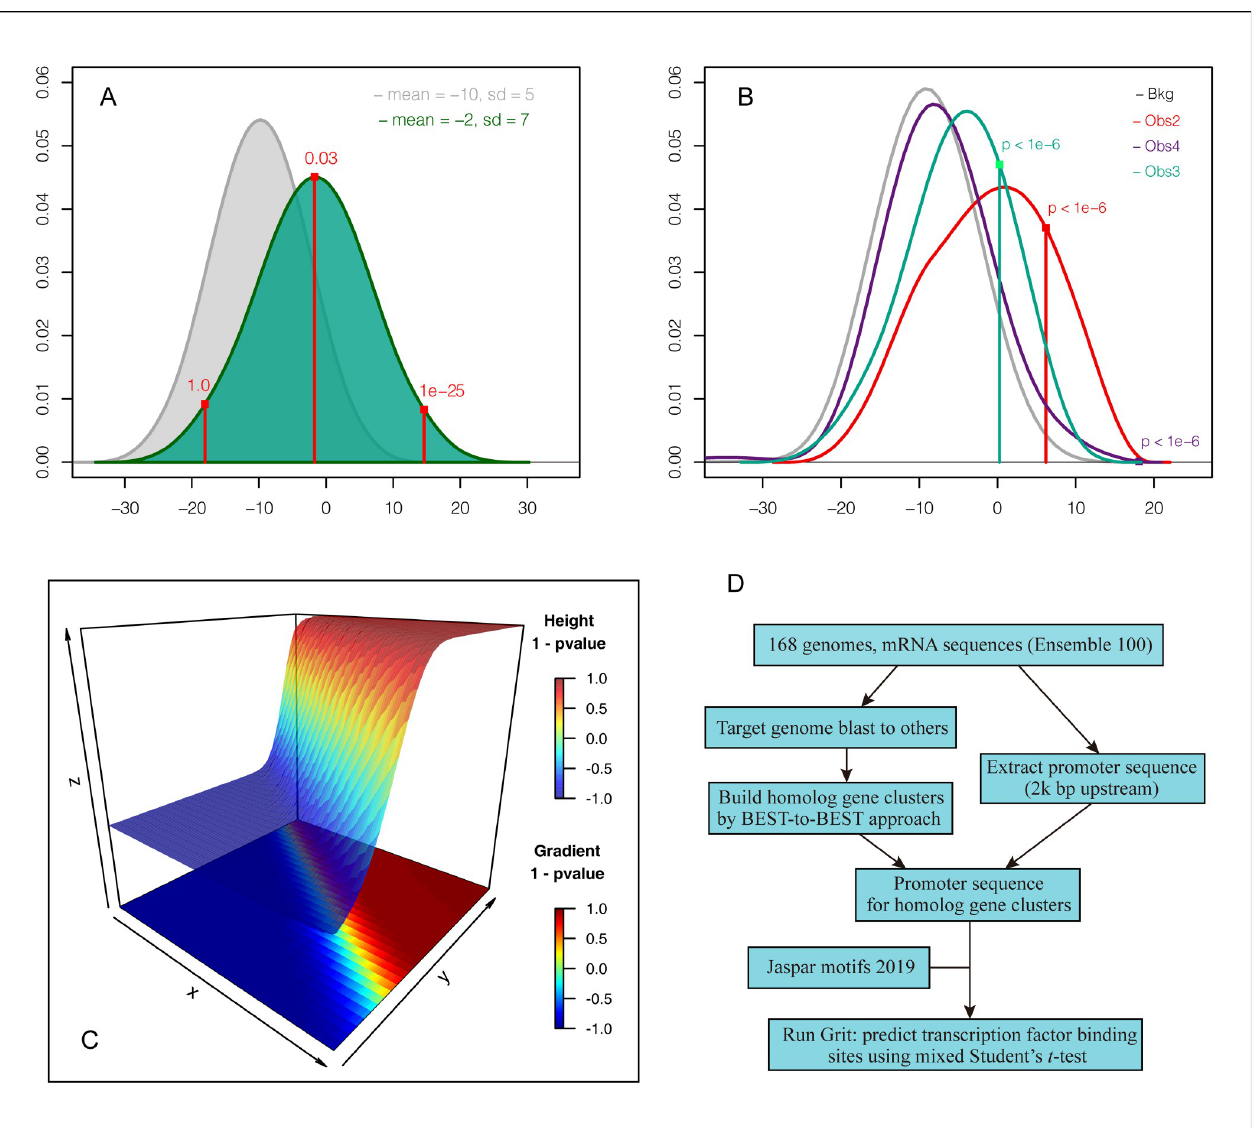
Fig 1. Validating the mixed Student’s t -test with simulated and real-world data. A and B. Simulated data and representative real-world data testing; the distribution of bkg was colored with gray, and obs with dark green; the one values of interest were indicated with vertical lines. C. Parameter testing. The X axis represented the coefficient of conserved variation ( CCV , 0 to 2.0), the Y axis represented the standard deviation ( SD , 0 to 3.0), and the Z axis represented the 1 − p -value. D. Schematic of the pipeline used for the